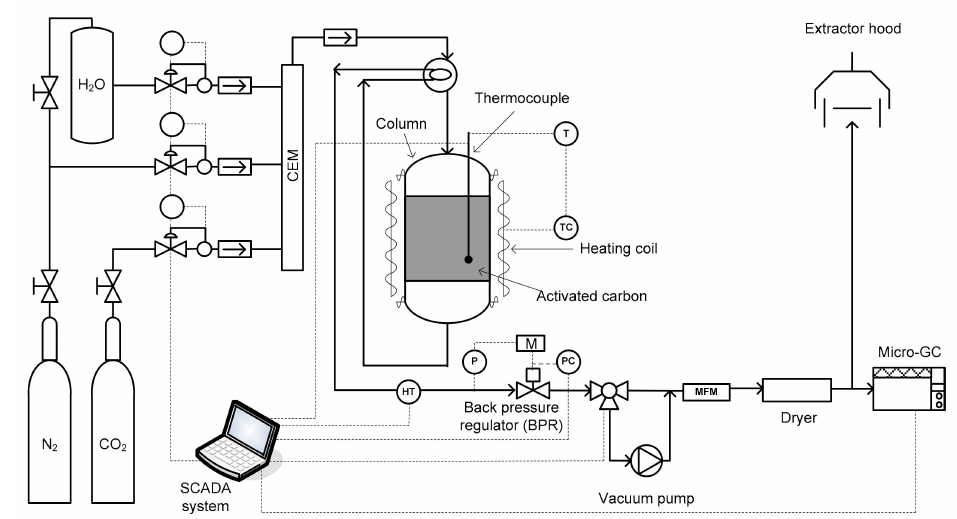
Figure 4. Experimental setup for the dynamic adsorption experiments.